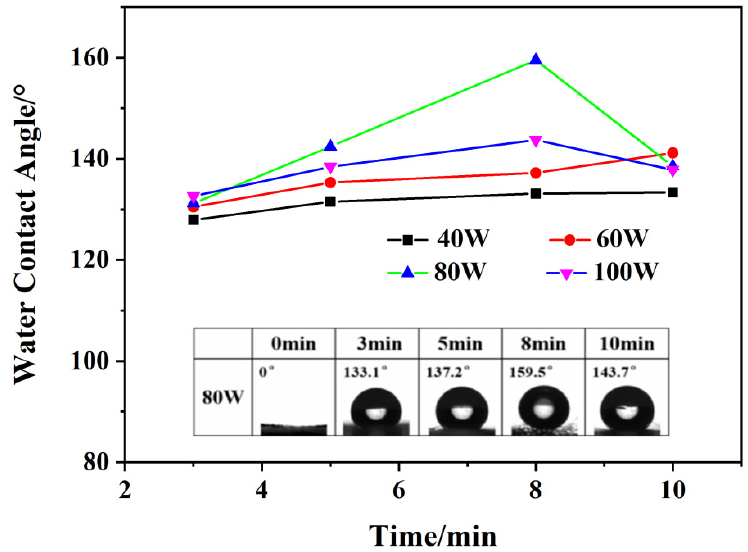
Figure 9. Water contact angle on the surface of CA fiber membrane after different plasma treatment (inset: water contact angle of the hydrophobic surface of CA fiber treated with different grafting time (80 W) and surface of untreated CA fiber).